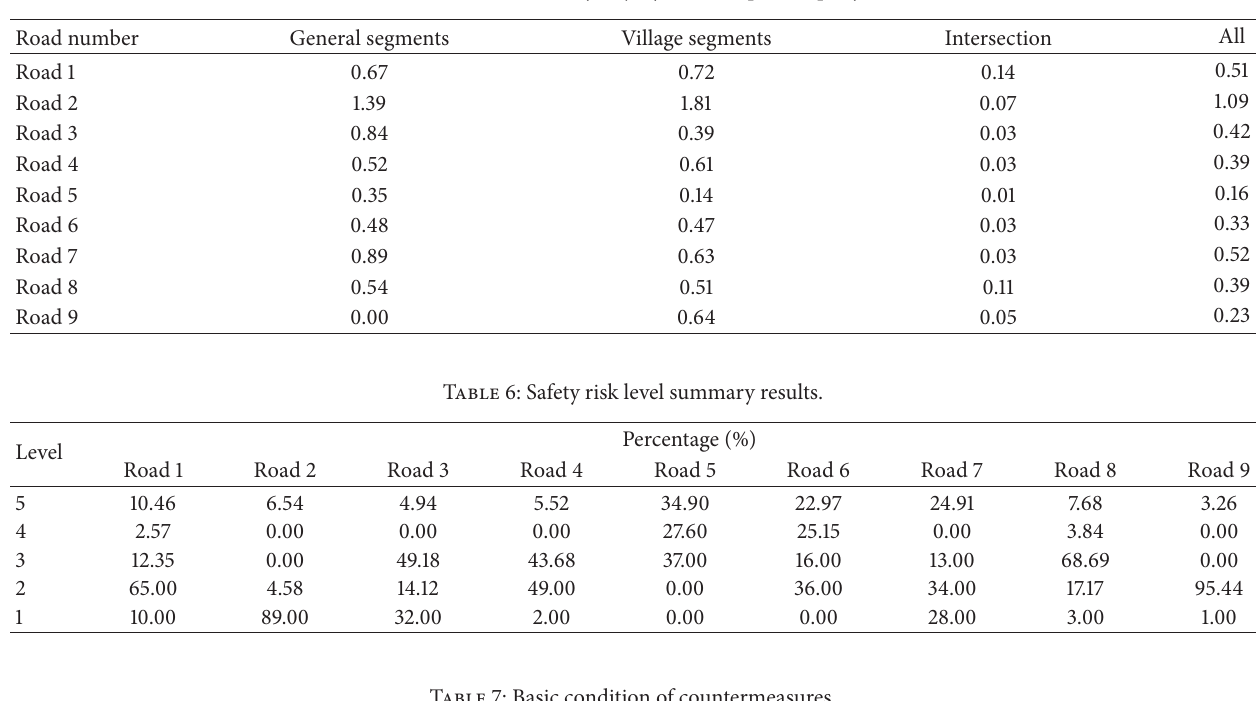
Table 5: Accident density (injury accident per km per year).